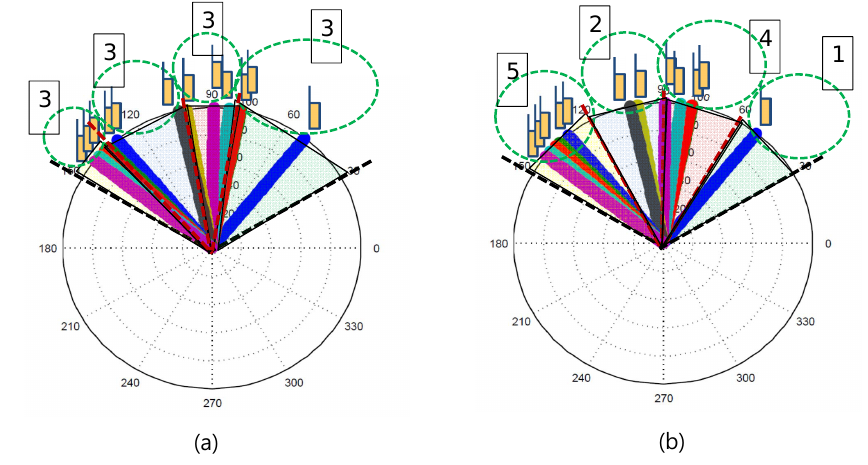
Figure 3. Sparse UE distribution (SUD) scenario, ( a ) the number of UEs; ( b ) the size of